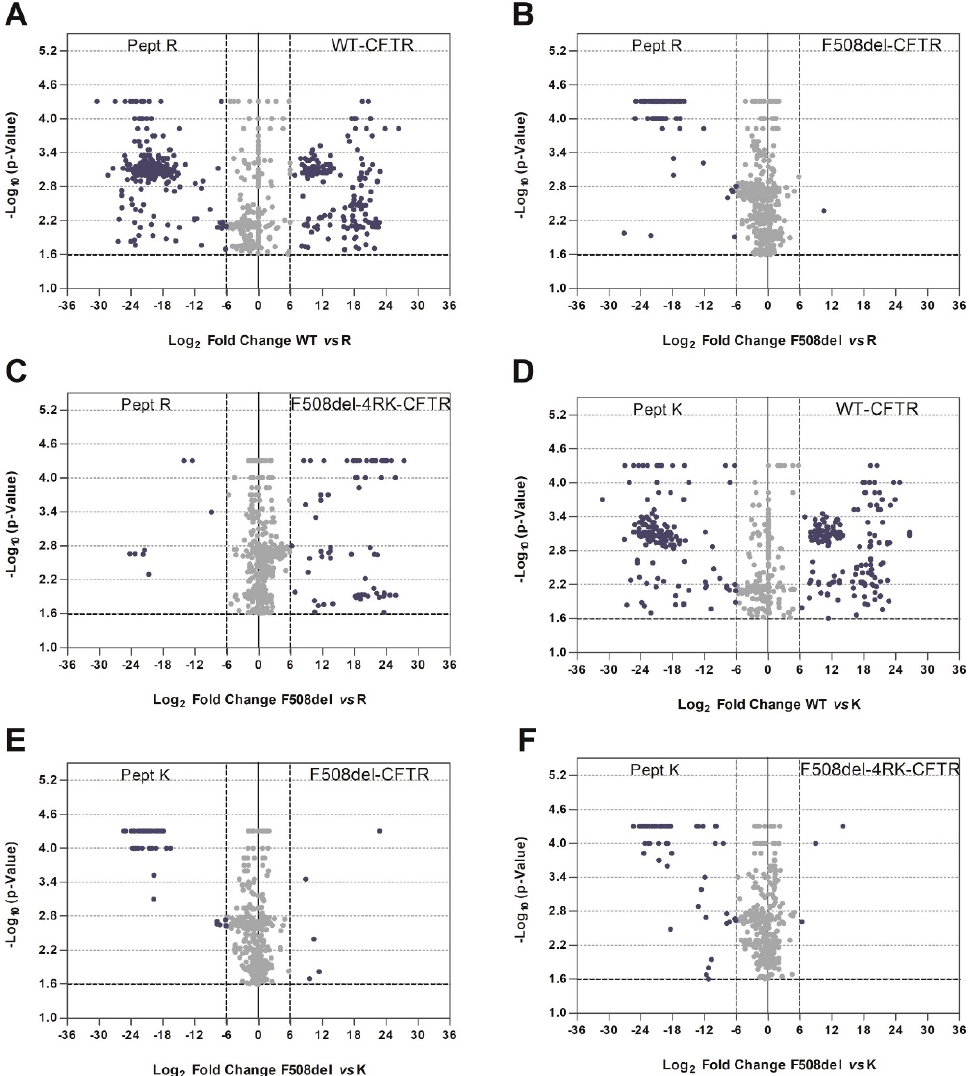
Figure 5. Volcano plots for pairwise comparisons of the interactomes related to AFT recognition. Significance is represented by − log 10 p -value calculated using permutation tests (10,000 permutations), and the protein affinity for the two variants under analysis is assessed as described in the text. Blue dots represent hits selected based on p -values < 0.025 and | fold change | > 6. A – F : Pairwise comparisons as included in the figure.